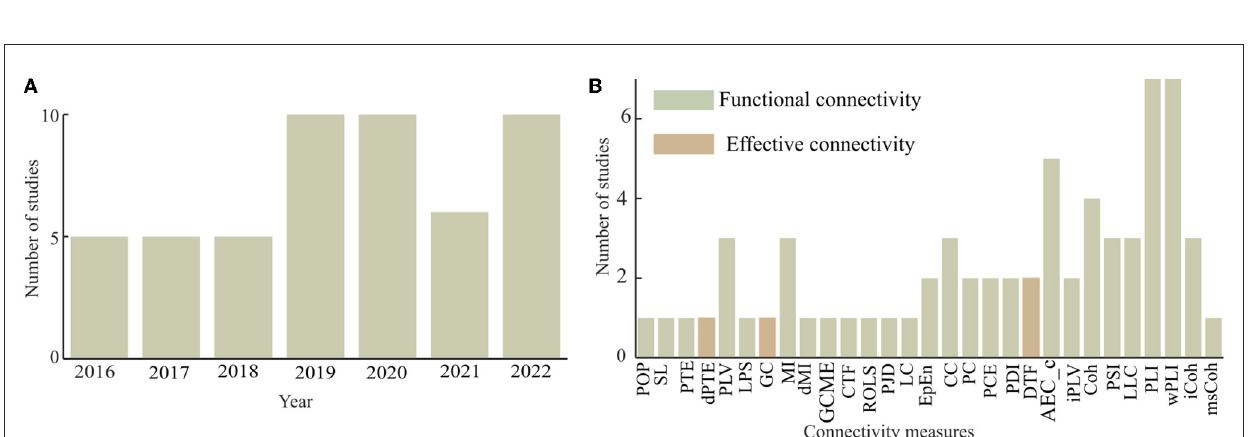
FIGURE4 Frequency of the usage of connectivity measures for dementia-related disorders with (A) annual distribution of the reviewed studies and (B) frequency distribution of the usage of connectivity measures.